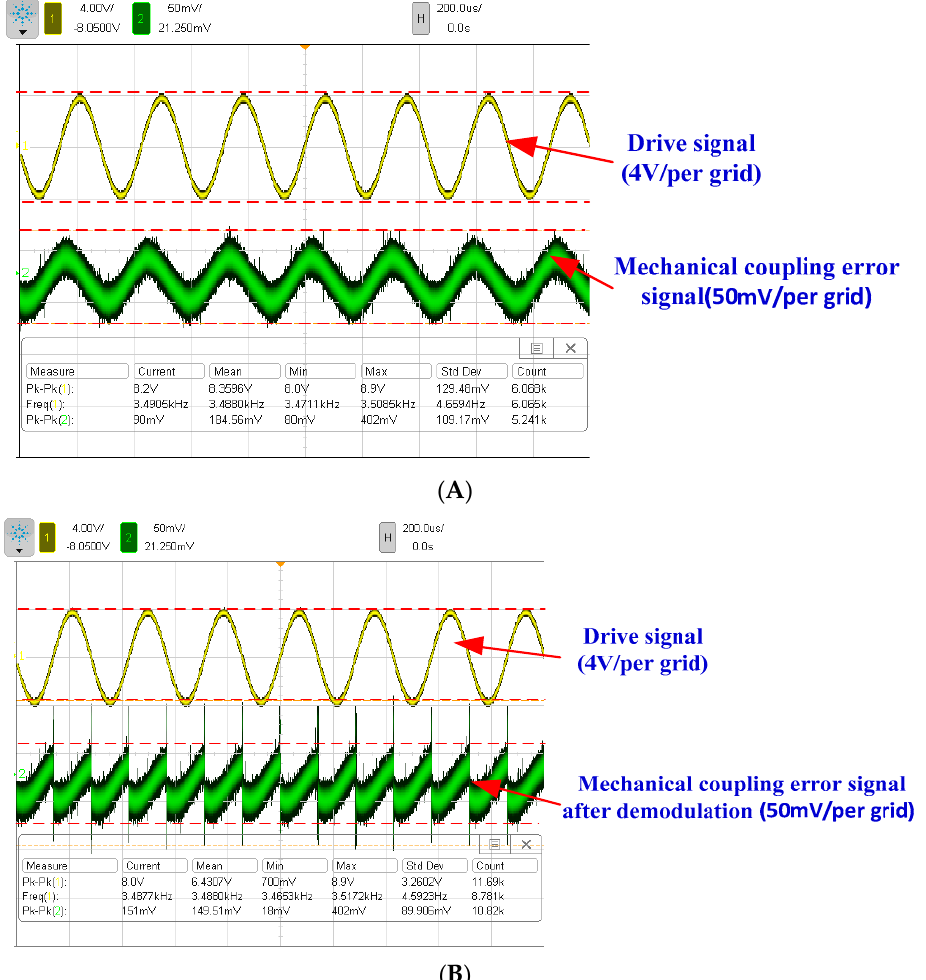
Figure 16. Mechanical coupling error measurement when the detection mechanism is exchanged with the driving mechanism. ( A ) The mechanical coupling error signal waveform of the pre-amplifier in the open loop sense (yellow signal is the reference drive signal in channel 1); ( B ) The mechanical coupling error signal waveform of the open loop sense after demodulation.